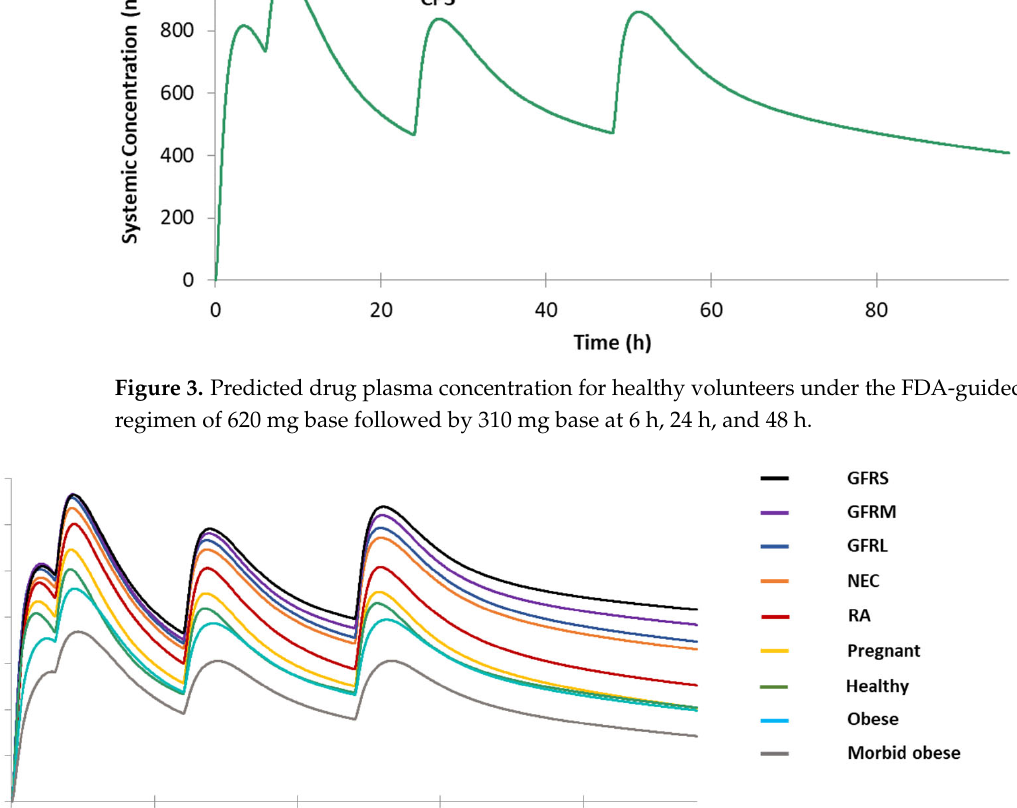
Figure 4. Predicted drug plasma concentration for healthy volunteers, pregnant population, NEC population, renal impairment populations, RA population obese population, and morbidly obese population under the same dosing regimen of 620 mg base followed by 310 mg base at 6 h, 24 h, and 48 h. GFRS: severe renal impairment populations, GFRM: moderate renal impairment population, GFRL: mild renal impairment population, NEC: geriatric Geriatric Northern European Caucasians population, RA: rheumatoid arthritis populations.